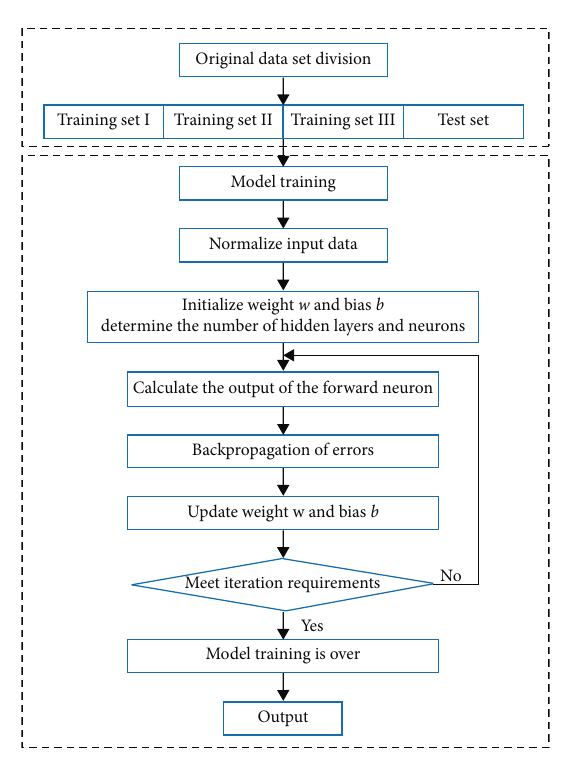
Figure 7: Proposed